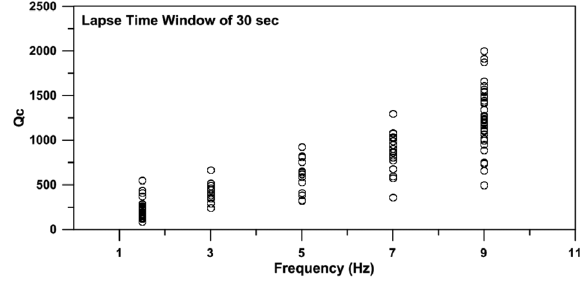
Figure 4. The plot of Q values as a function of frequency obtained c at 30 sec lapse time